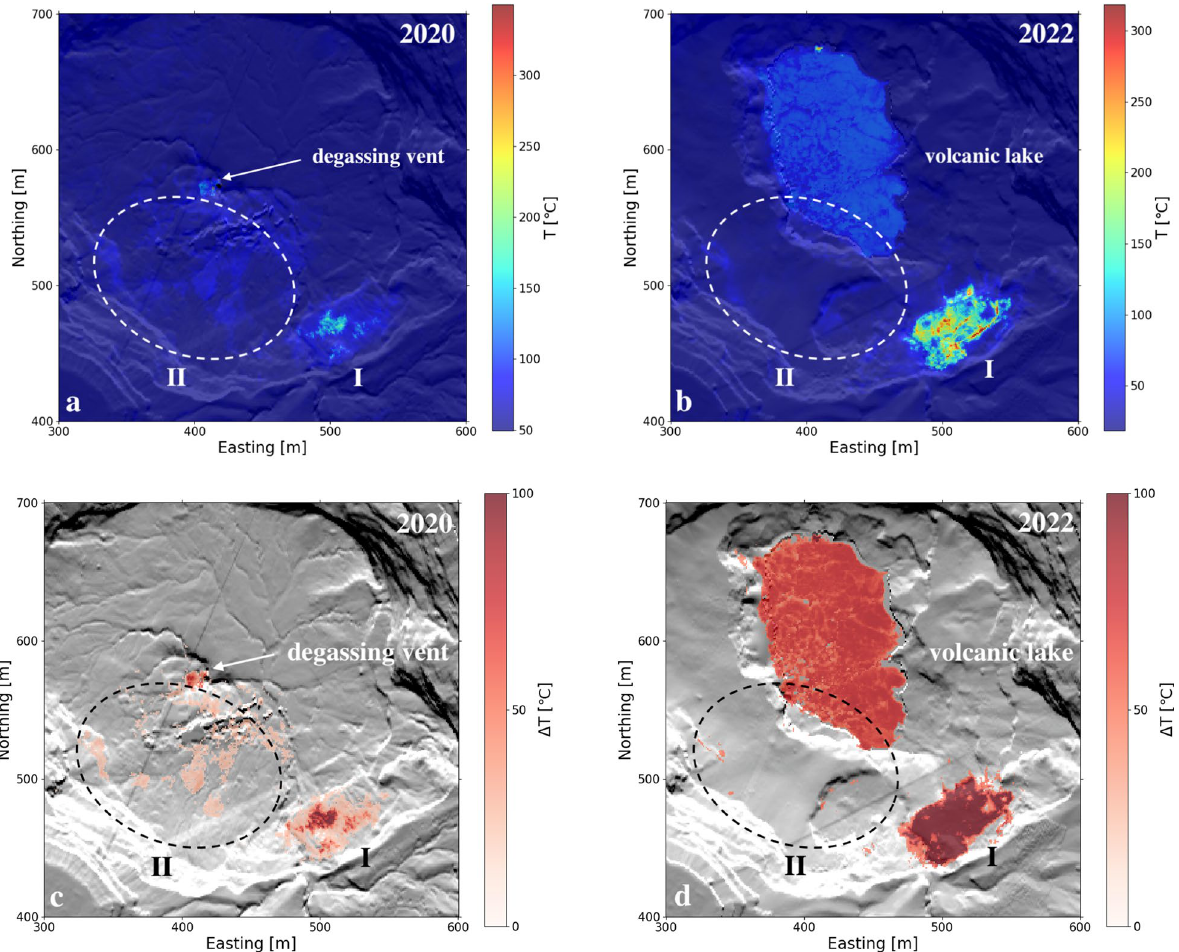
Fig. 6 Orthorectified thermal images zoomed in on the first crater ( a 2020 survey and b 2022 survey) and thermal anomalies ( c 2020 and d 2022). Both maps a and b show a high-temperature fumarolic field on the south crater wall (I) and steaming grounds scattered on the crater floor and southwest wall